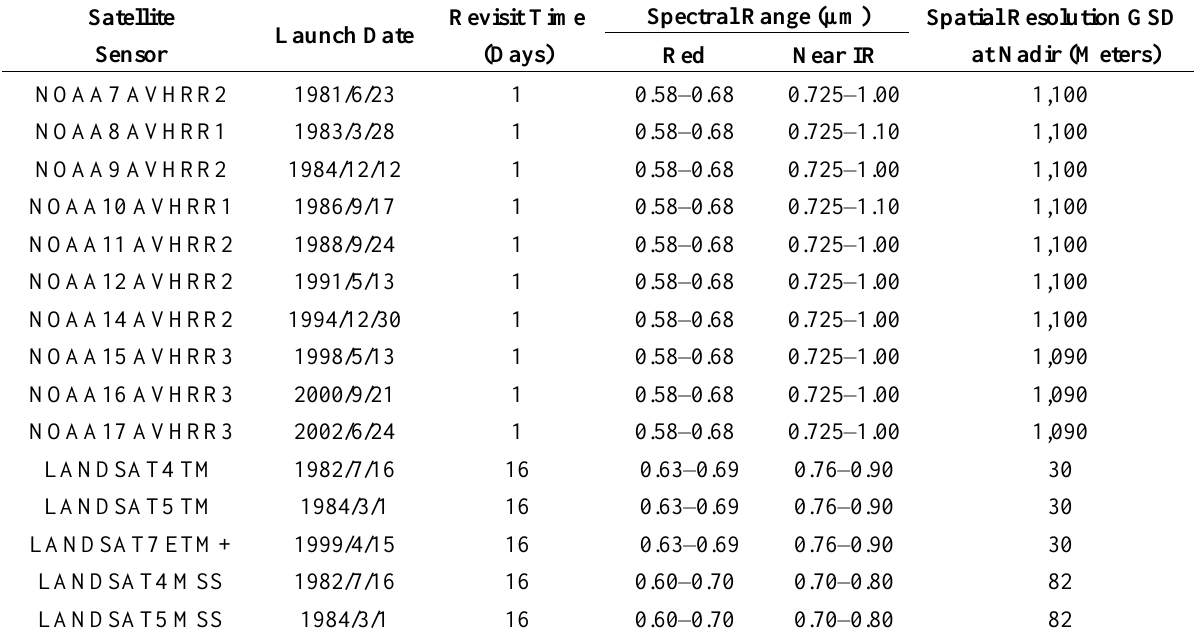
Table 1. Characteristics of satellite sensors used in this